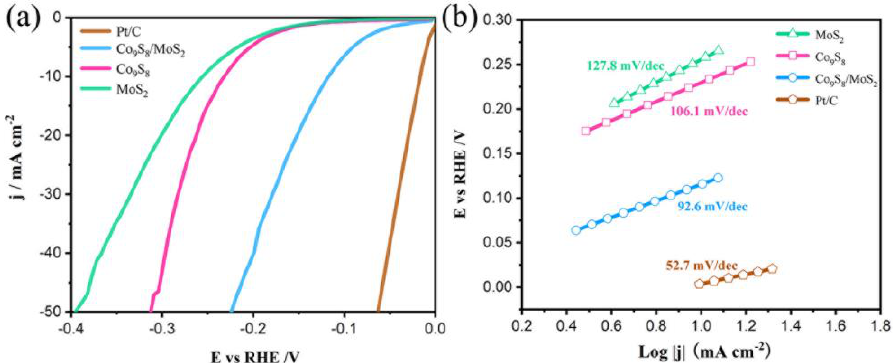
Figure 7. ( a ) Co 9 S 8 , MoS 2 , Co 9 S 8 /MoS 2 and Pt/C polarization curves in 1 M KOH; ( b ) the corresponding Tafel plots. Table 1. Comparison of HER activity for Co 9 S 8 /MoS 2 in this work and other reported electrocatalysts (1 M KOH).